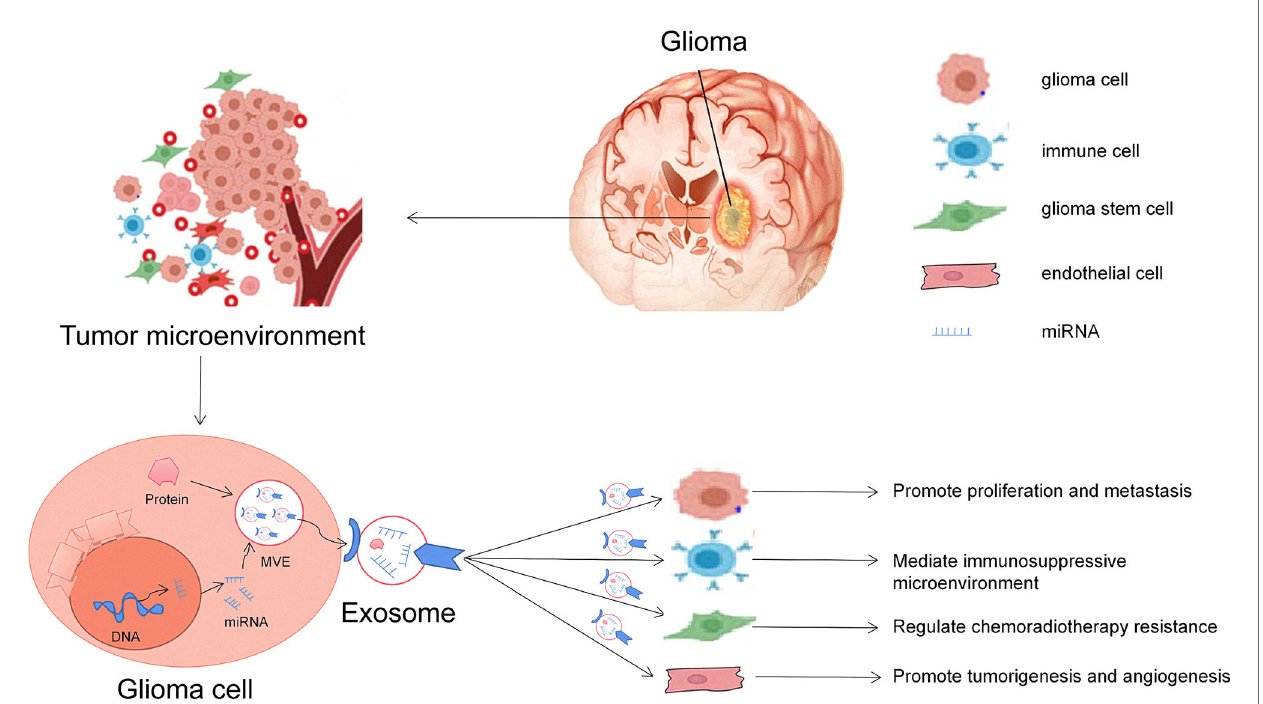
FIGURE 2 | Roles of glioma-derived exosomes in glioma development. The fi rst general mechanism is glioma cells can communicate with other cells via exosomal miRNAs in the tumor microenvironment. The second general mechanism is that exosomes derived from glioma cells alter the behavior of normal cells, including promoting glioma carcinogenesis, angiogenesis, and drug resistance and helping cancer cell escape from host immune system, and can be useful diagnostic and/or prognostic